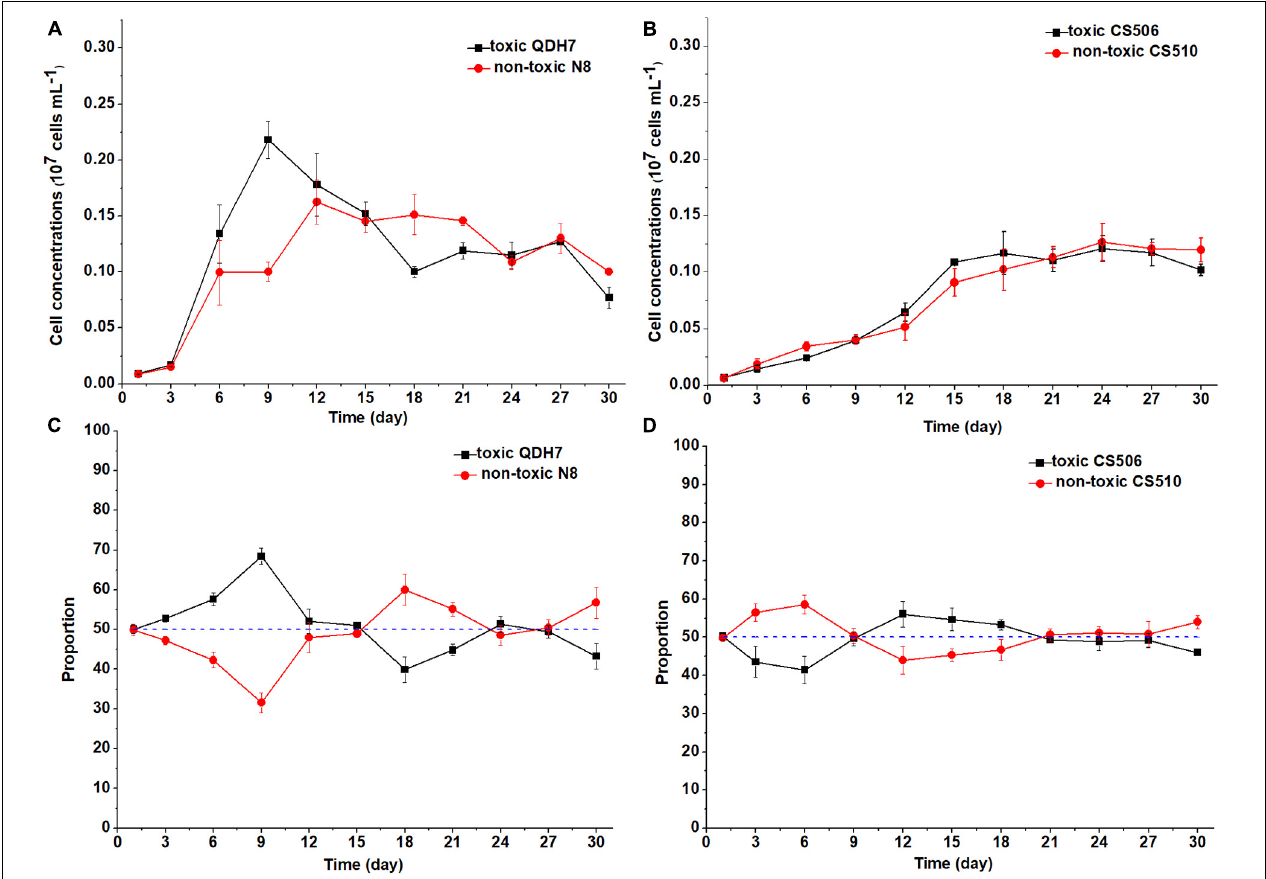
FIGURE 6 | Changes in cell concentrations of toxic ( cyrJ copy numbers) and non-toxic (the differences between rpoC1 and cyrJ copy numbers) R. raciborskii , and proportion of toxic and non-toxic strains under N-limited (N3) condition. Panels (A,C) showed data for QDH7/N8 co-culture experiments, whereas panels (B,D) showed data for CS506/CS510 co-culture experiments. These experiments were started with equal amounts of CYN-producing and non-CYN-producing cells (1:1, blue dotted line in panels (C,D)